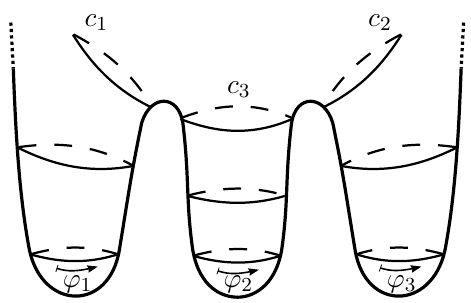
Figure 9 . A cartoon of the B -cycle of the triple throat, n = 3 and m = 2. The local c -axion excursions c 1 ; c 2 and c 3 , c i = Re ^ G i , must be chosen so that no overall (cid:13)ux is generated on B , ^ G i = i.e. 0 ! = c 1 + c 2 + c 3 , 21 or rather P i